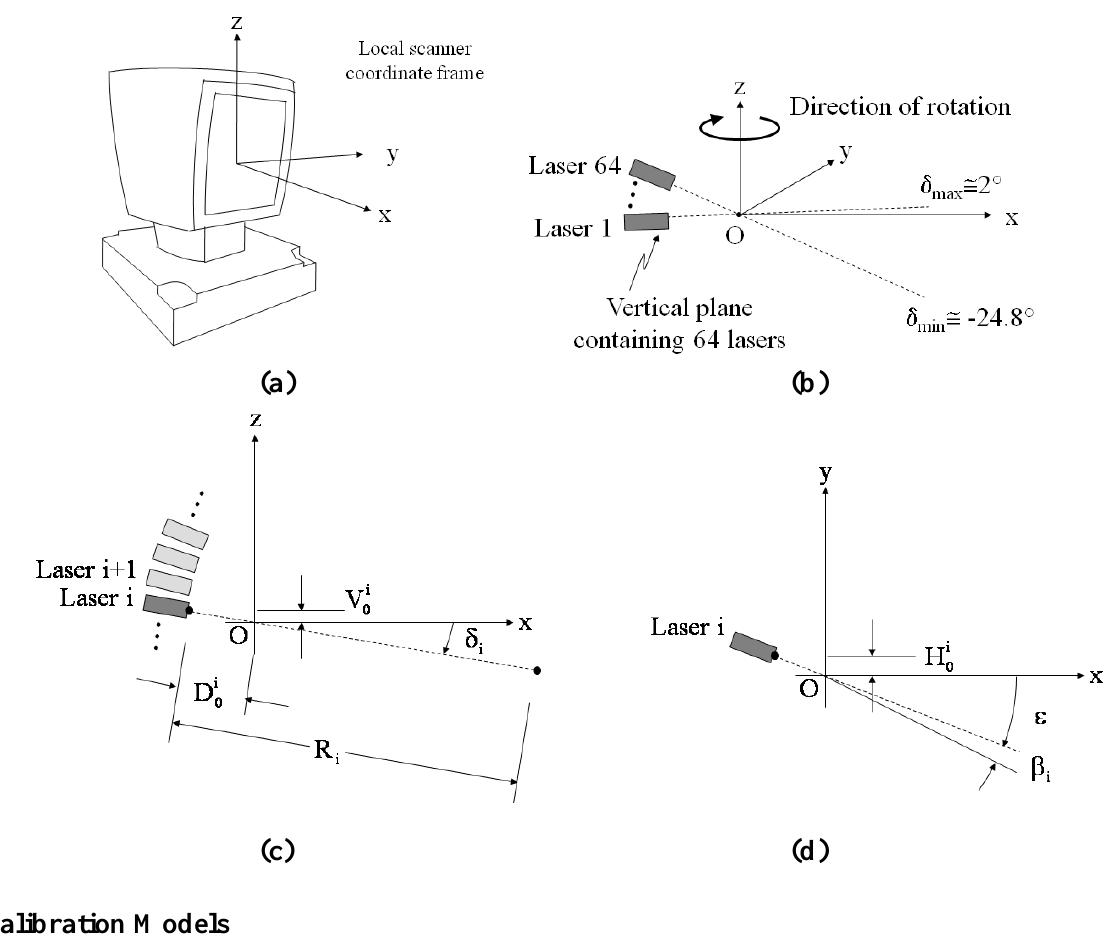
Figure 2. (a) Scanner frame axes. (b) Scanner layout. (c) Scanner Parameters in Vertical Plane. (d) Scanner Parameters in Horizontal